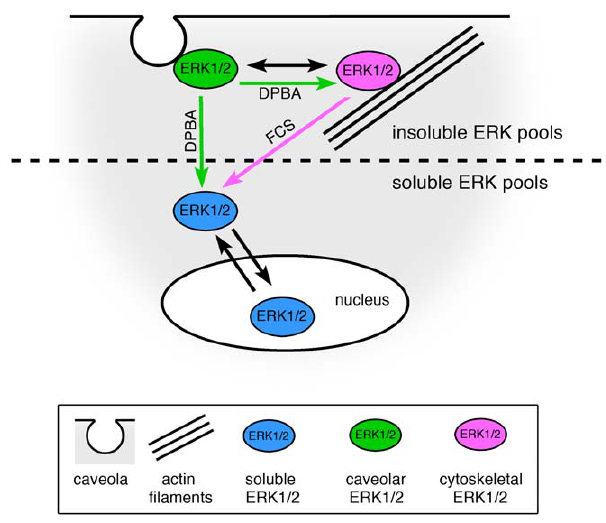
Figure 6. Model: Spatially distinct ERK1/2 subfractions are activated in a stimulus-specific manner. Upon FCS stimulation, a cytoskeletal ERK1/2 fraction is activated and released into a soluble ERK1/2 fraction (magenta arrow), enabling nuclear ERK1/2 signaling, whereas the caveolar ERK1/2 fraction is not activated in response to FCS. Phorbol ester stimulation, in contrast, leads to phosphorylation of both, caveolar and cytoskeletal ERK1/2 fractions. Caveolar ERK1/2 is released upon activation (green arrows), while cytoskeletal ERK1/2 is retained at actin filaments. The double headed arrow indicates a functional link between the caveolar and cytoskeletal ERK1/2 fractions.